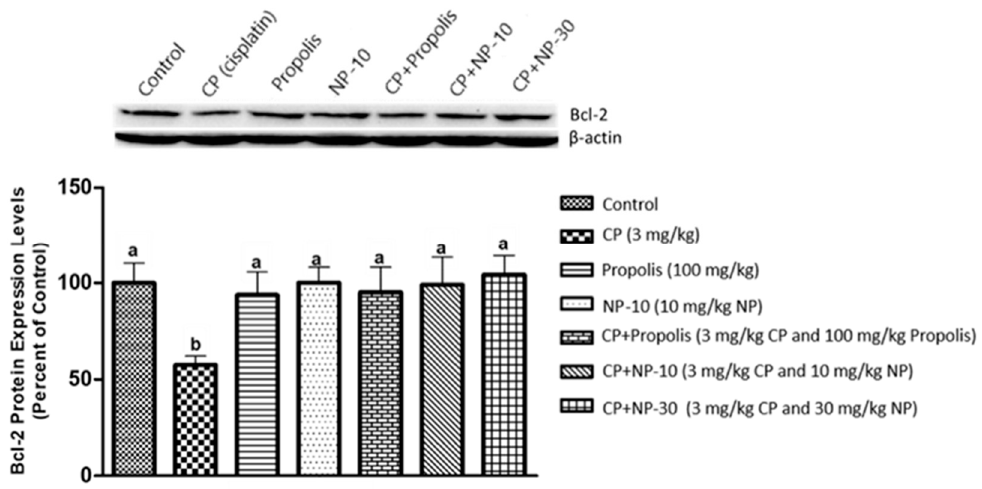
Figure 5. Bcl-2 protein expression levels in kidney tissue. a,b,c: Mean values within a row differ significantly, Significance is p < 0.001 (NP: nano-propolis).